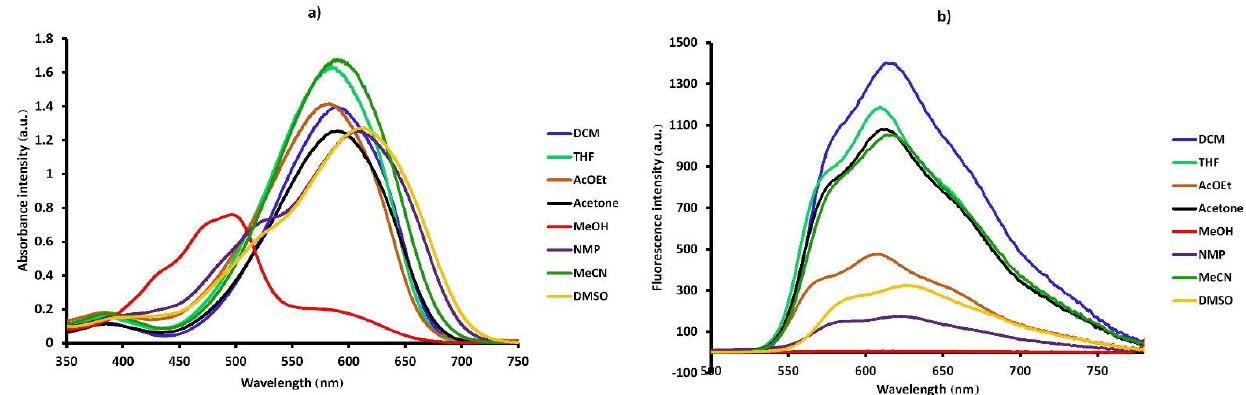
Figure 7. Absorption ( a ) and fluorescence ( b ) intensity spectra of 1-(4-ethoxy)phenylazonaphthalen-2-ole difluoroborane ( 6 ) in solvents of different polarity. Table 2. Photophysical properties of compounds 5 – 8 .